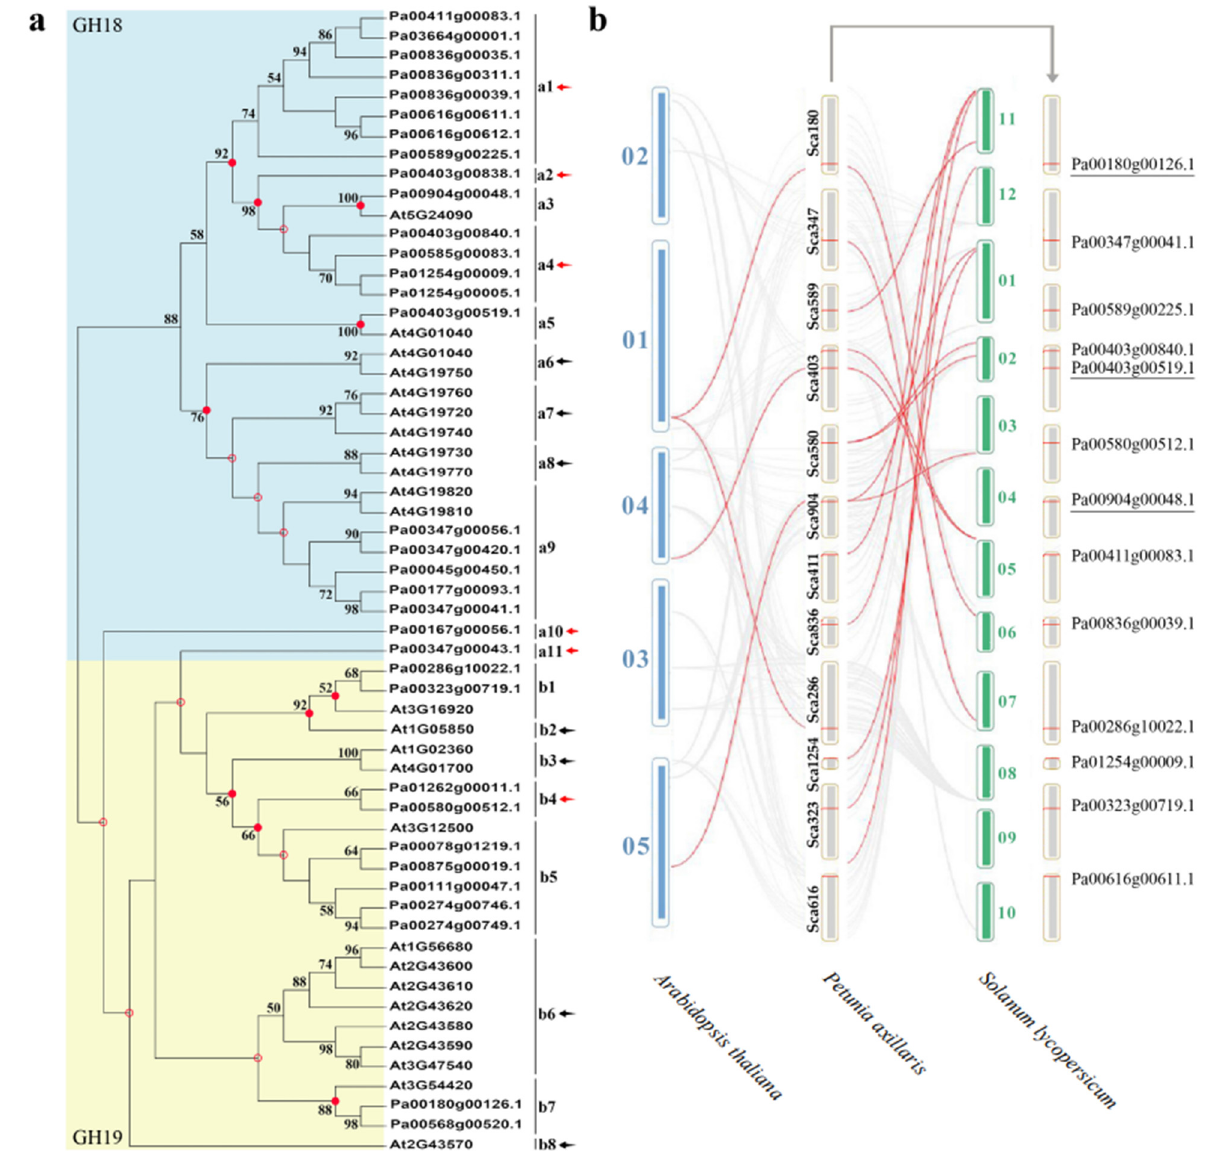
Figure 3. Phylogenetic tree construction and homeology analysis. ( a ) The phylogenetic tree of CTLs from P. axillaris and A. thaliana . Numbers on branches indicate the bootstrap percentage values calculated from 1000 replicates, and only values higher than 50% are shown. The nodes that represent the most recent common ancestral genes before the P. axillaris and A. thaliana split are indicated by red dots (bootstrap support > 50%) and hollow dots (bootstrap support < 50%). Clades that contain only P. axillaris and A. thaliana CTLs are indicated by red and black arrows, respectively. ( b ) The homeology analysis of CTLs from petunia, Arabidopsis and tomato genomes. The gray lines in the background indicate the homologous relationship within P. axillaris and the other two plant genomes, while the red lines highlight the members of the CTL gene family that have a homologous relationship between two genomes .